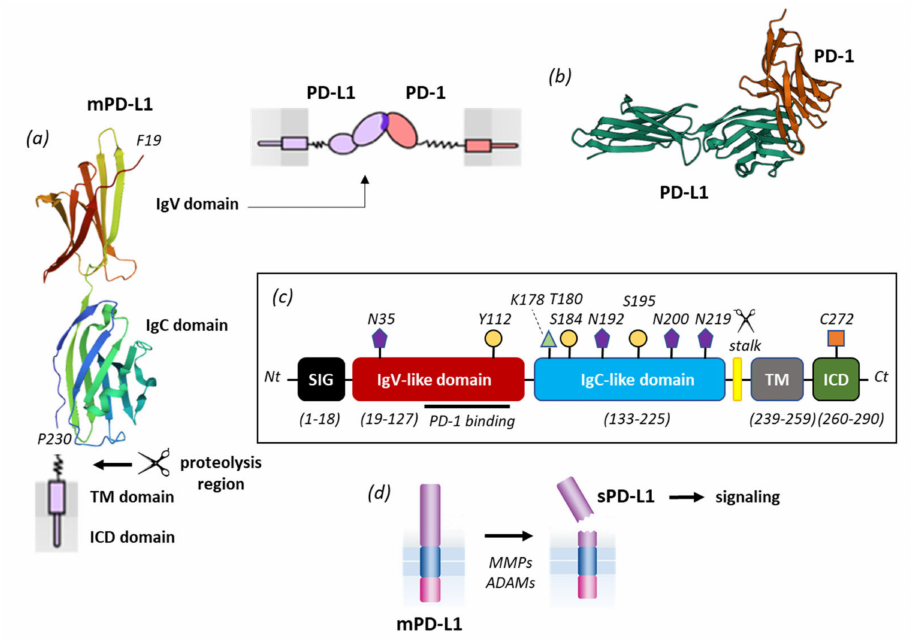
Figure 3. PD-L1 primary structure and processing. ( a ) mPD-L1 with its IgV domain (which interacts with PD-1) and IgC domain linked to the transmembrane domain (TM) via a short flexible stalk. The TM domain is connected to the intracellular (ICD) domain. The molecular model of PD-L1 derives from the crystal structure of the free protein (PDB access code 3BIS). ( b ) Model of PD-1 interacting with PD-L1 via its IgV domain. ( c ) Primary structure of mPD-L1 with the different domains and sites of post-translational modifications ( N -glycosylation at N35, N192, N200 and N219; phosphorylation at Y112, T180, S184, S195, ubiquitination at K178 and palmitoylation at C272). Proteolytic cleavage generally occurs within a short stalk region situated between the IgC and TM domains. ( d ) Representation of mPD-L1 shedding by different proteases (MMPs, ADAMs) to release a soluble form of PD-L1, which plays a role in cell